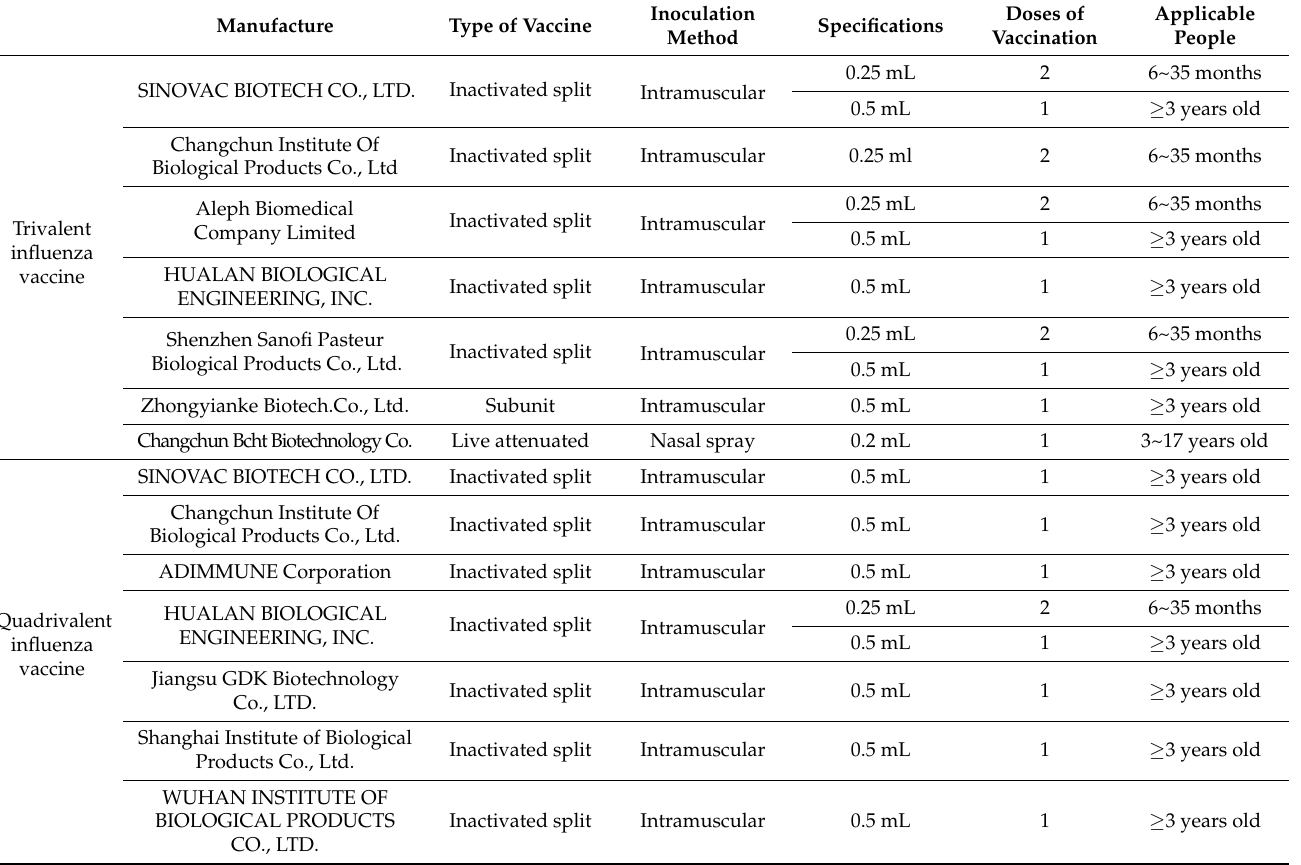
Table 1. Influenza vaccine approved and issued in